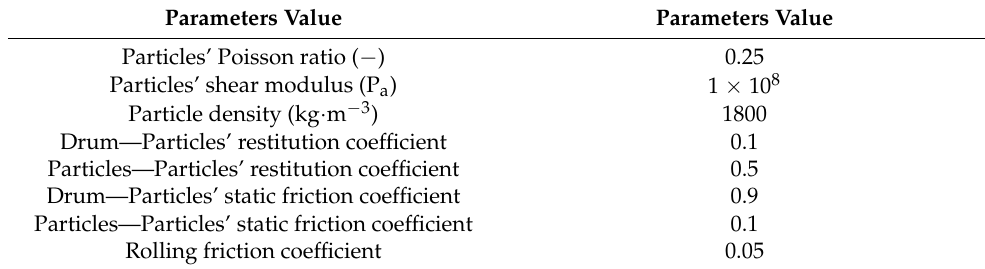
Table 2. Physical and mechanical properties of particles.